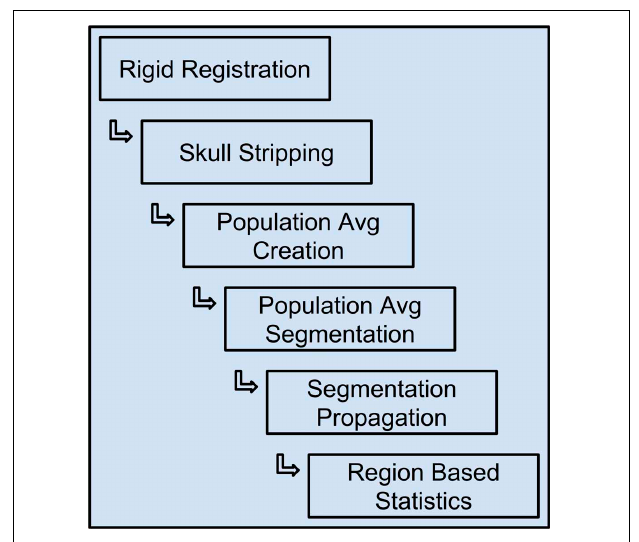
FIGURE 12 | The constructed pipelines used for rodent brain image